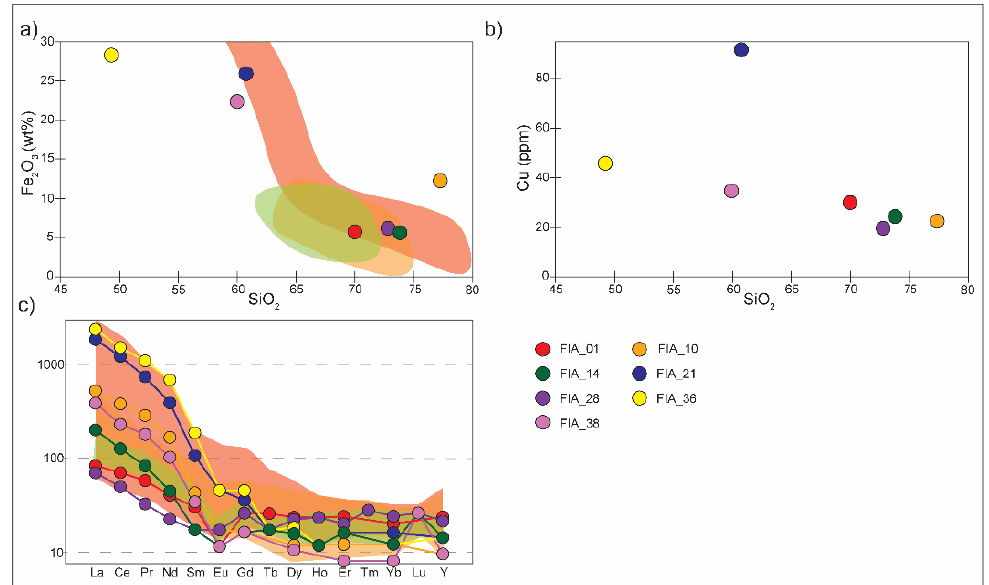
Figure 3. Whole-rock geochemical data for basal diamictite samples used in this study. ( a ) Bivariate plot of SiO 2 vs. Fe 2 O 3 ; ( b ) bivariate plot of SiO 2 vs. Cu; ( c ) Chondrite normalised REE diagrams displaying REE patterns for samples used in this study. Data normalised to values of [52]; sample locations are shown in Figure 1b. Fields show whole-rock geochemistry of regional unaltered (green) and altered (orange) Donington Suite, and Donington Suite from the Carrapateena deposit (red) (data from [15]).